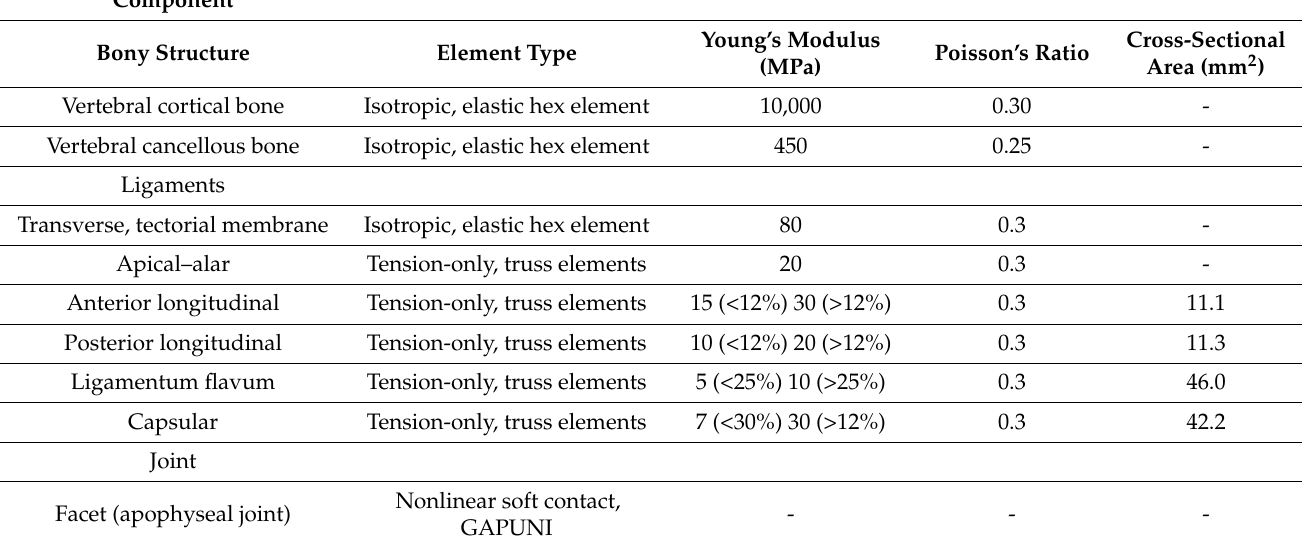
Table 1. Material properties for different components of the cervical spine finite element (FE) model